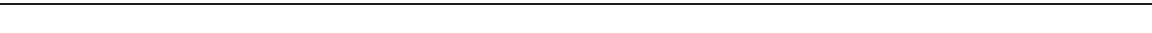
Fig. 6 Butyrate inhibits pathogenicity of WT Th1 cells but not Prdm1 − / − Th1 cells in induction of colitis. WT and Prdm1 − / − Th1 cells were cultured with APC and anti-CD3 mAb in the presence or absence of C4 for 5 days, and then injected i.v. into groups of Rag − / – mice ( n = 4). Six weeks post-T-cell transfer, the severity of intestinal in fl ammation was assessed. a , b Colonic histopathology ( a ) and histological scores ( b ) are shown. Scale bar, 100 μ m. ** p < 0.01 Mann – Whitney U -test. c LP CD4 + T-cell cytokine production was determined by fl ow cytometry. d Bar charts of the percentage of cytokine- expressing CD4 + T-cells. e Colonic tissue cytokine production after 24 h of cultures was determined by ELISA. Data are one representative of three independent experiments. * p < 0.05 one-way ANOVA